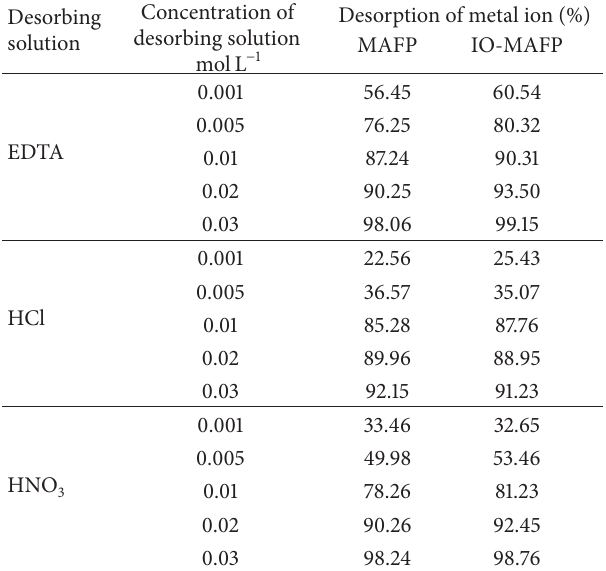
Table 6: Desorption studies of Co(II) from MAFP and IO-MAFP biomasses. Desorbing